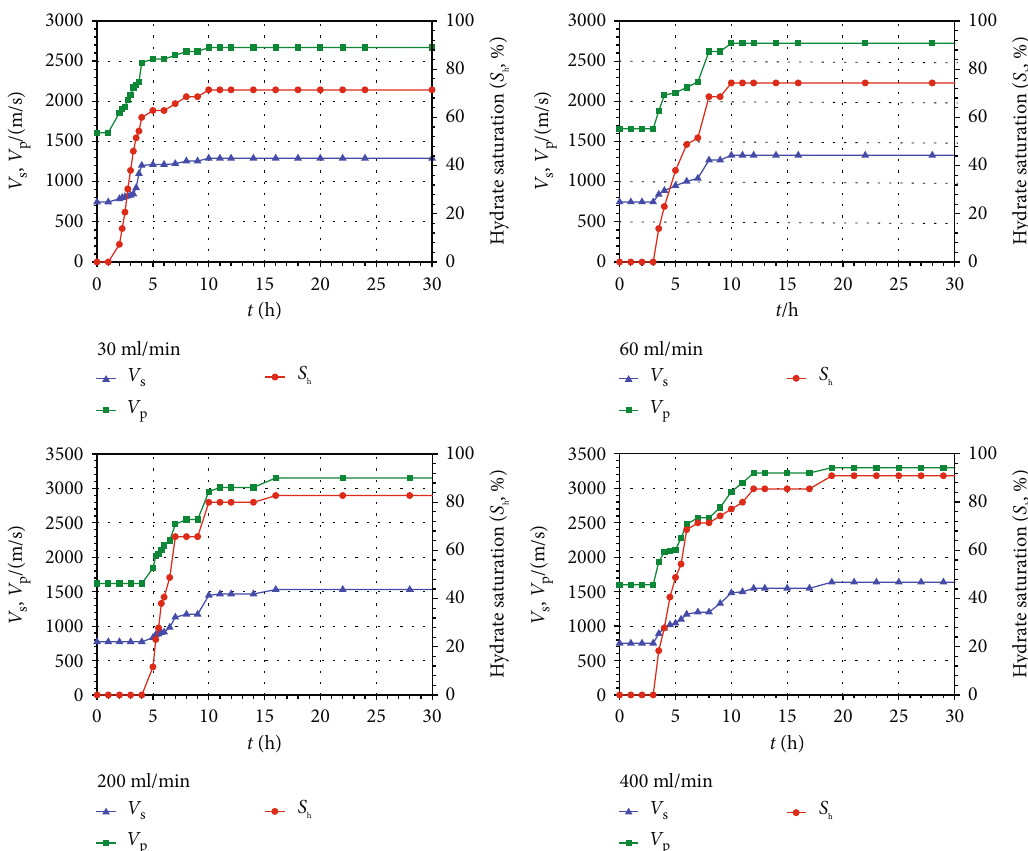
Figure 3: Variation in hydrate saturation and wave velocity during hydrate formation (30 ml/min 、 60 ml/min 、 200ml/min 、 400ml/min), (Data for Figure 3 are in Table S5 in the Supplementary